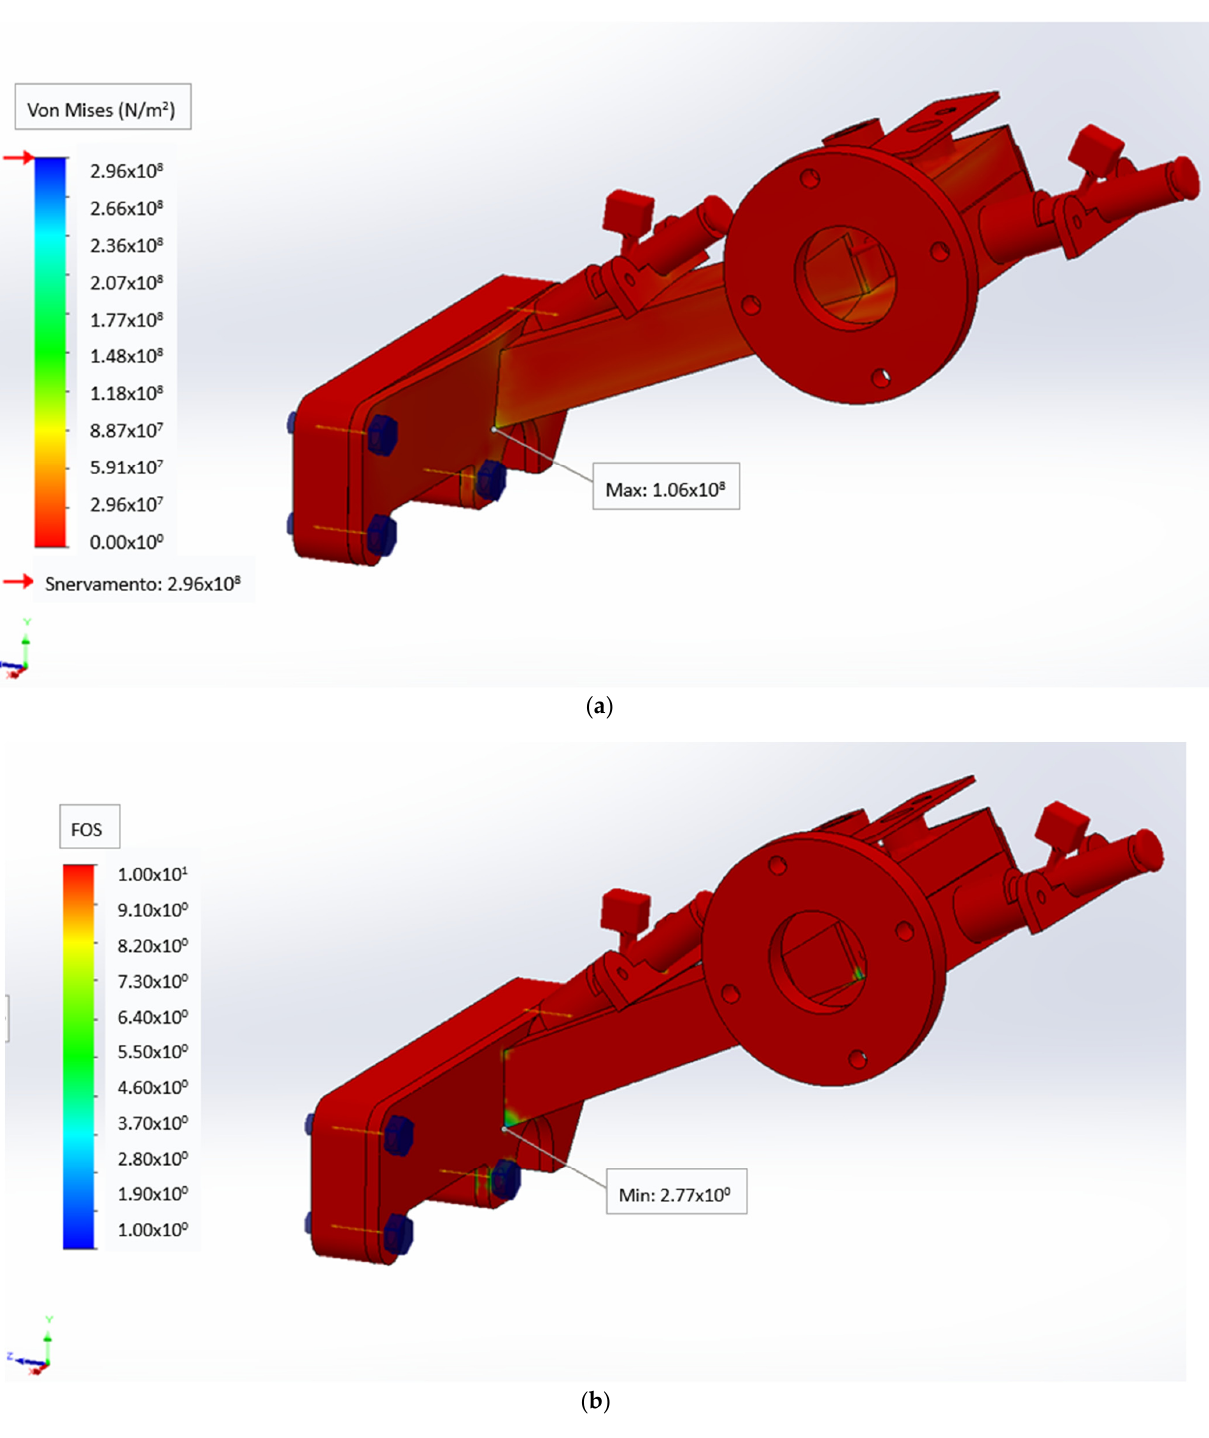
Figure 3. FEM static approach: stress analysis result ( a ) and safety factor (FOS) evaluation ( b ); two injectors are also shown fitted in the port- and manifold wall.